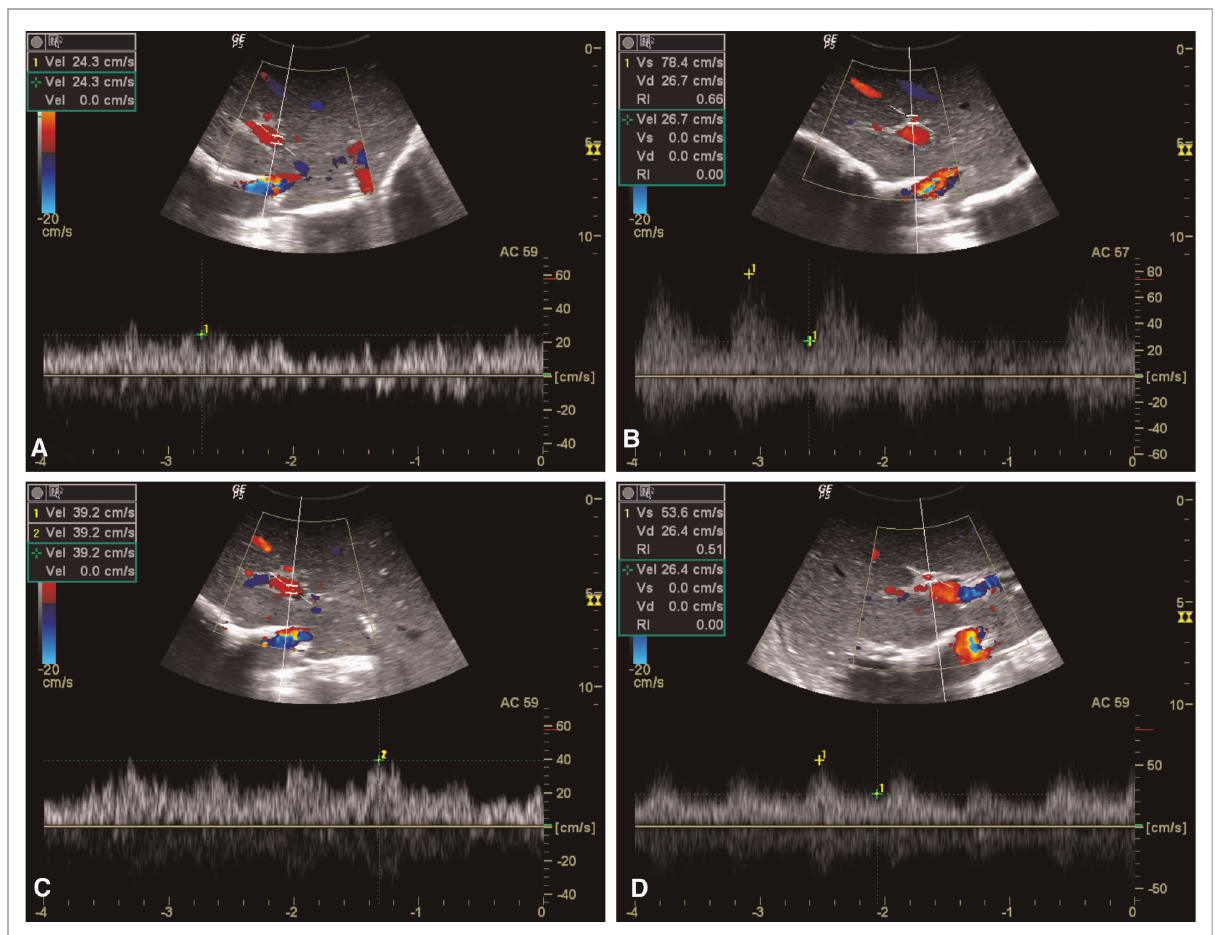
FIGURE 4 Hemodynamic consequences of test clamping of SRS. ( A, C ) PV fl ow increased markedly after test clamping of the SRS, from 24.3 cm/s ( A ) to 39.2 cm/s ( C ). ( B, D ) Decreased PSV of HA in response to SRS blocking from 78.4 cm/s ( B ) to 53.6 cm/s ( D